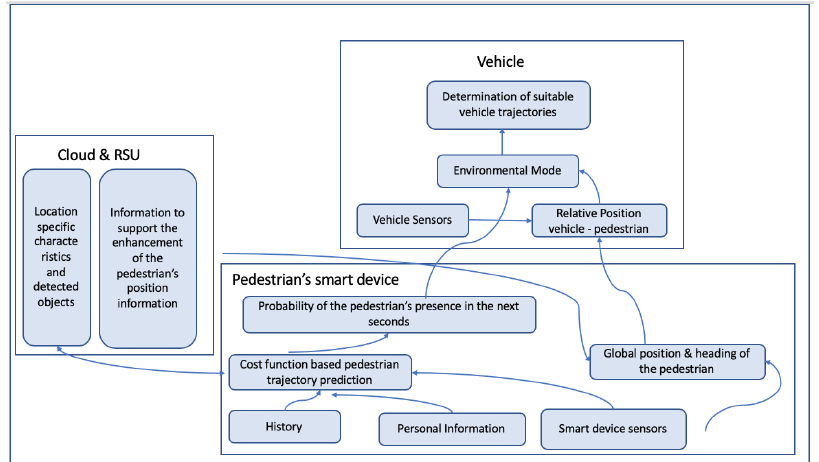
Figure 2. Proposed system in Reference [30].